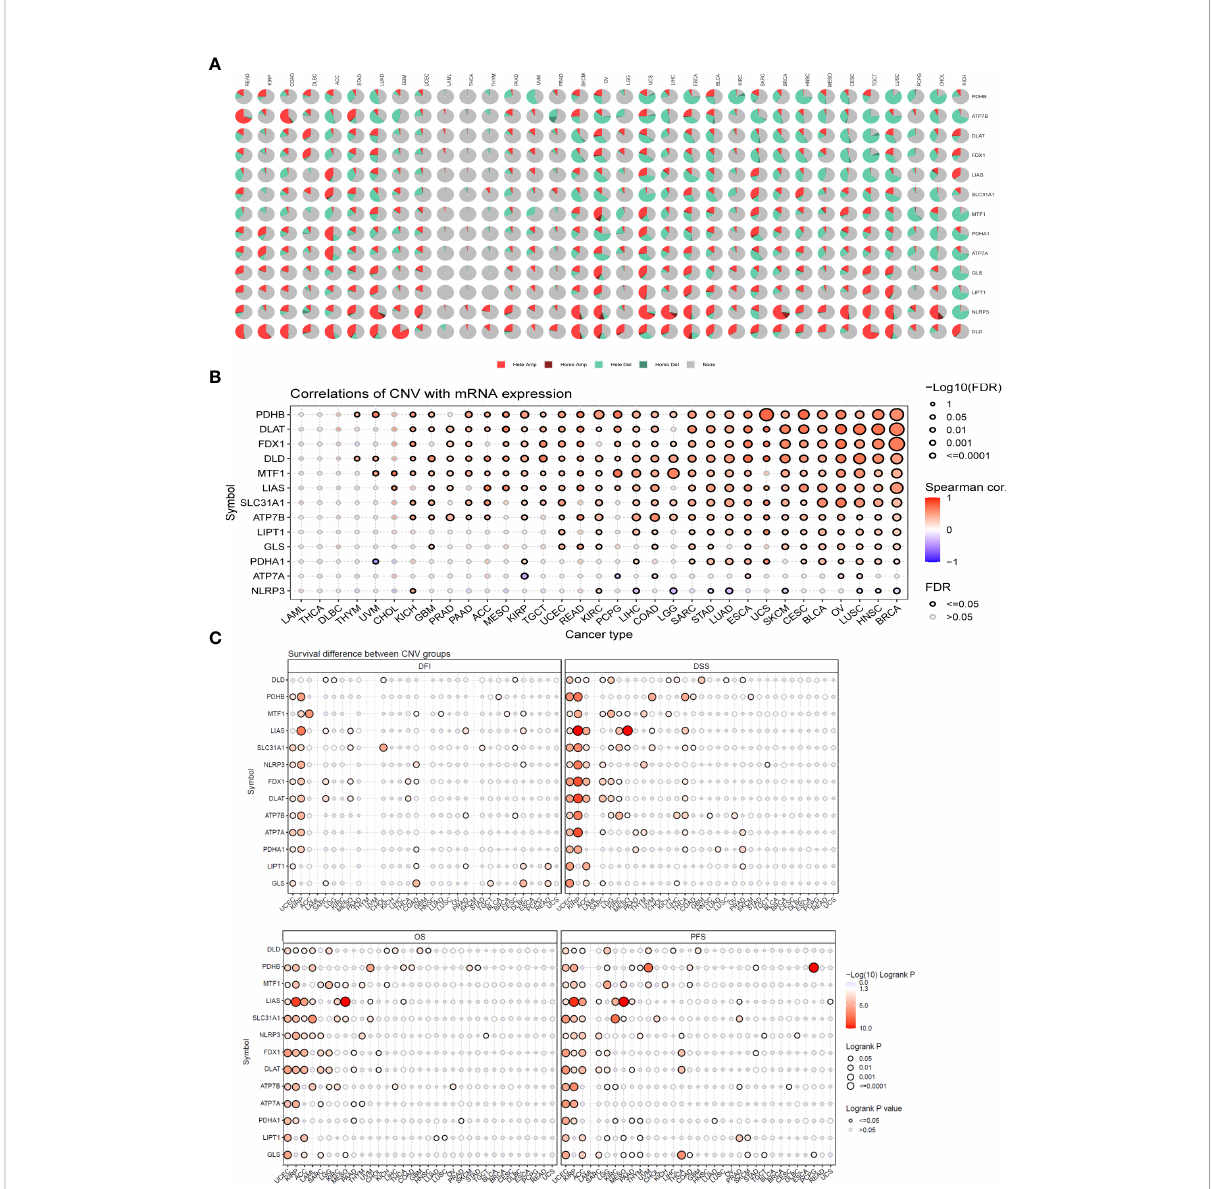
FIGURE 6 CNV analysis of cuproptosis-related genes (GSCALite). (A) Pie chart summarizing the CNVs of cuproptosis-related genes in pan-cancer, namely, heterozygous ampli fi cation (Hete Amp), homozygous ampli fi cation (Homo Amp), heterozygous deletion (Hete Del), homozygous deletion (Homo Del), and diploid (none). (B) The correlation between CNVs and mRNA expression was analyzed via Spearman correlation analysis. The blue dots represent negative correlations, and the red dots indicate positive correlations; the darker the color, the higher the correlation. The size of the dots represents statistical signi fi cance, with larger dots being more signi fi cant. (C) Differences in survival between the mutant and WT of each gene in the cuproptosis-related gene set. If the hazard ratio (HR) was >1, the CNV group was considered to have a higher risk of death; otherwise, the WT group was considered to have a higher risk of death. CNV, copy number